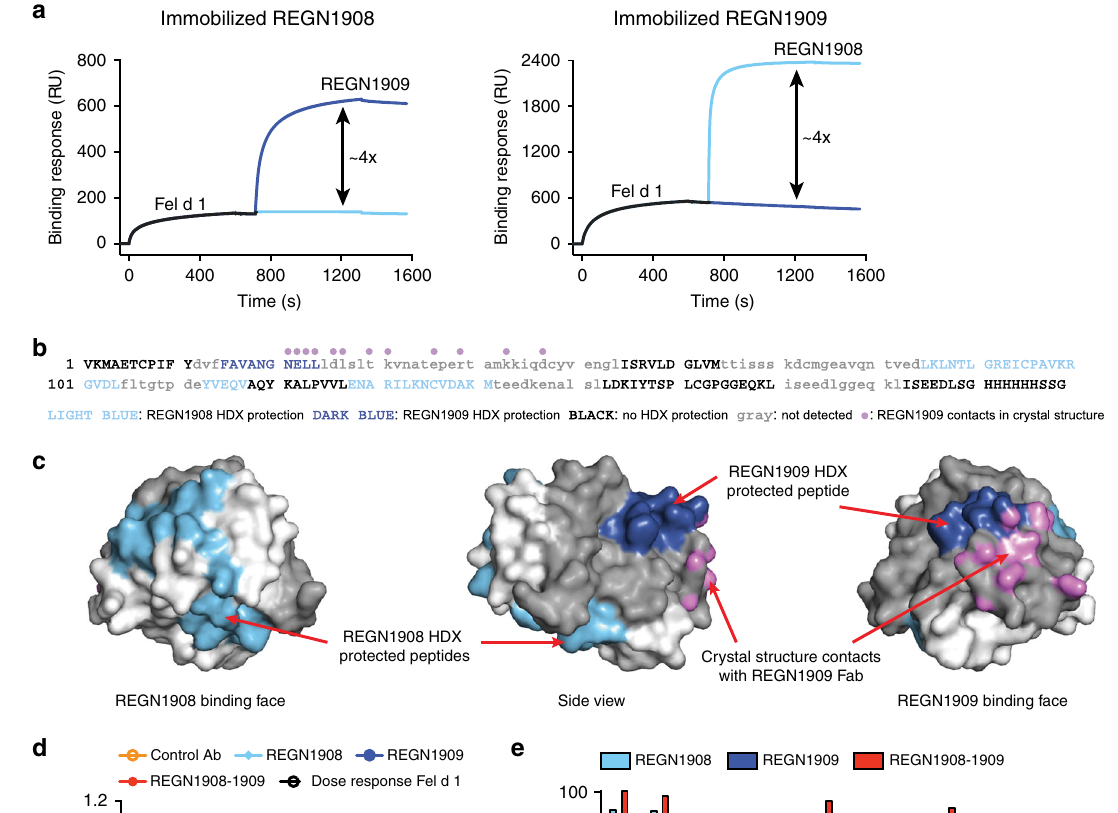
These data establish that REGN1908 and REGN1909 bind with high af fi nity, simultaneously, and in a non-competing fashion to Fel d 1, and are more effective in combination when blocking Fel d 1 binding to polyclonal IgE from patients with cat allergy. REGN1908 – 1909 inhibits mast cell degranulation in vivo . The potency of REGN1908 and REGN1909 was evaluated in vivo using the passive cutaneous anaphylaxis (PCA) mouse model with either nFel d 1 or cat hair extract, which contains